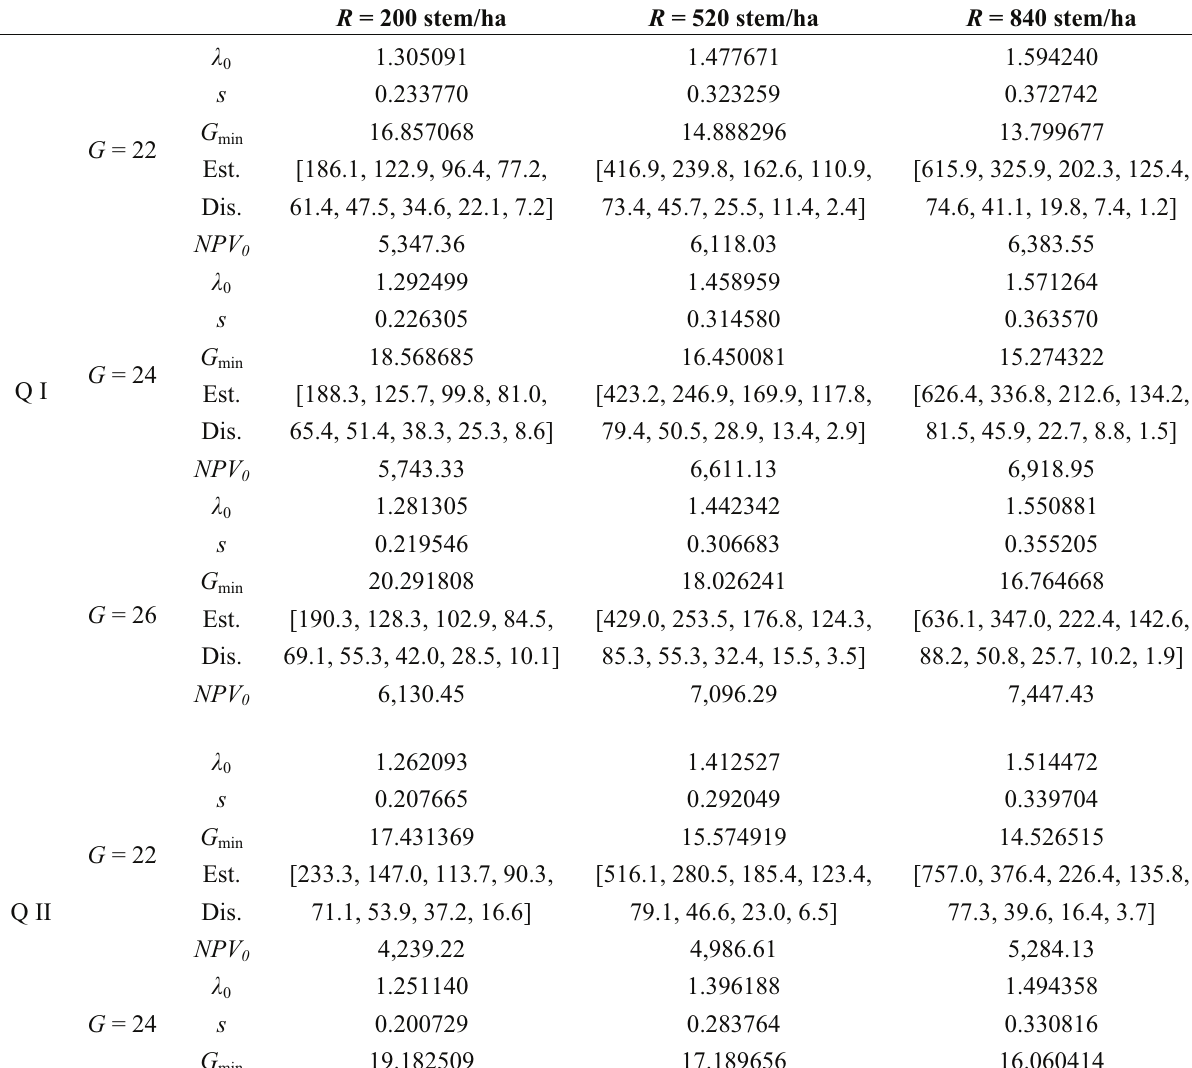
Table 2. Numerical values for (cid:2) , s , stable distributions and NPV 0 quality class I–III; (cid:2) , population growth rate without harvests; s , stable harvest rate; G , 0 basal area in m 2 /ha; Est. Dis., stable diameter distribution in stem/ha; NPV value under the stable equilibrium in €/ha for i =